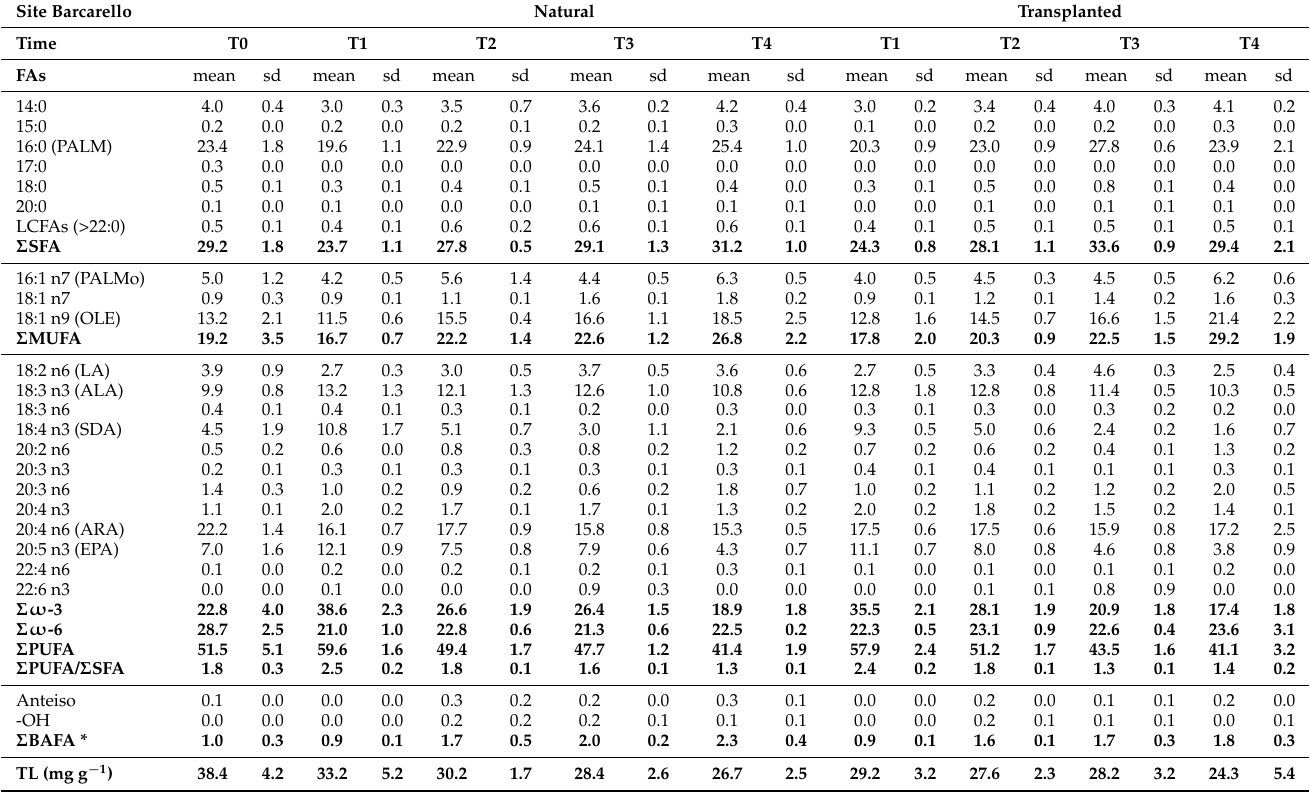
Table 1. Fatty acid relative abundance (mean ± standard deviation % of total FAs) of natural and transplanted Ericaria amentacea thalli, throughout the experiment at the Barcarello site. The concentration of total lipids (TL mg g − 1 ) is also reported. The sums of the different fatty acid categories and total lipids are highlighted in bold.